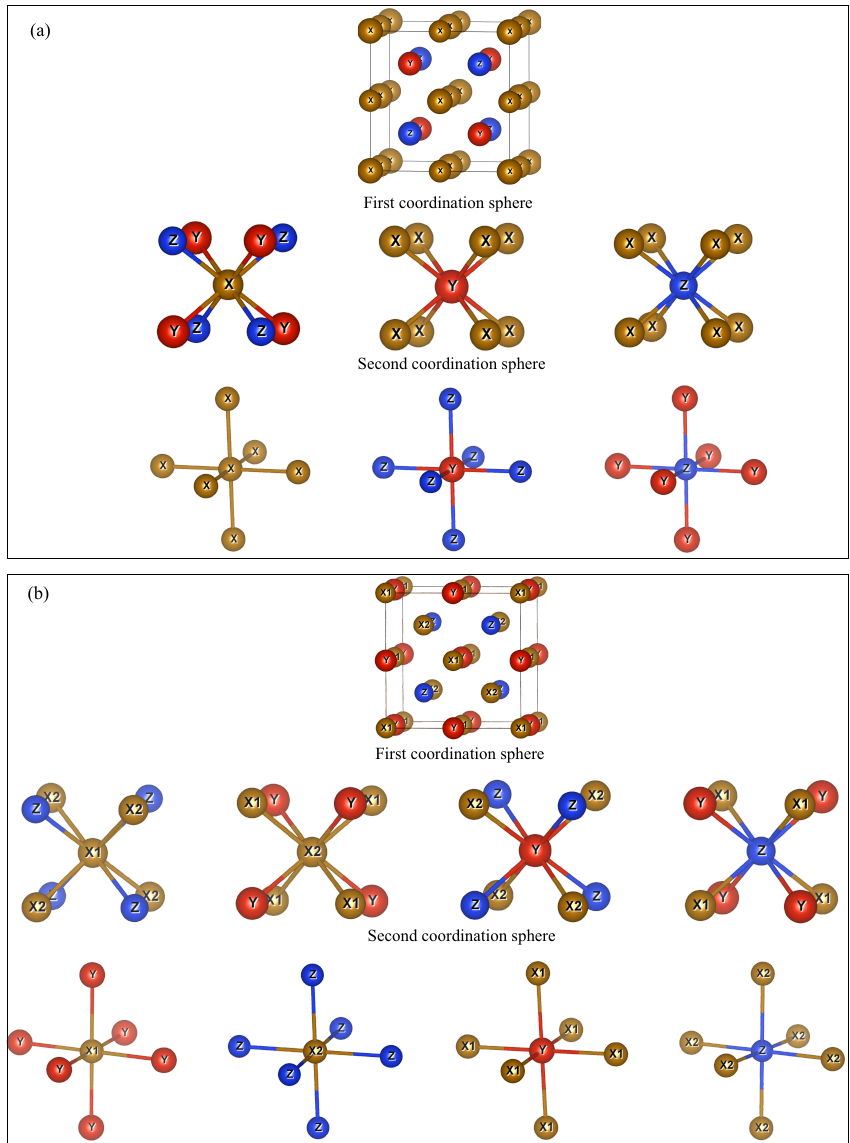
Figure 1. Crystal structure and nearest and next-nearest local environment of Heusler compounds in ( a ) L 2 1 and ( b ) XA